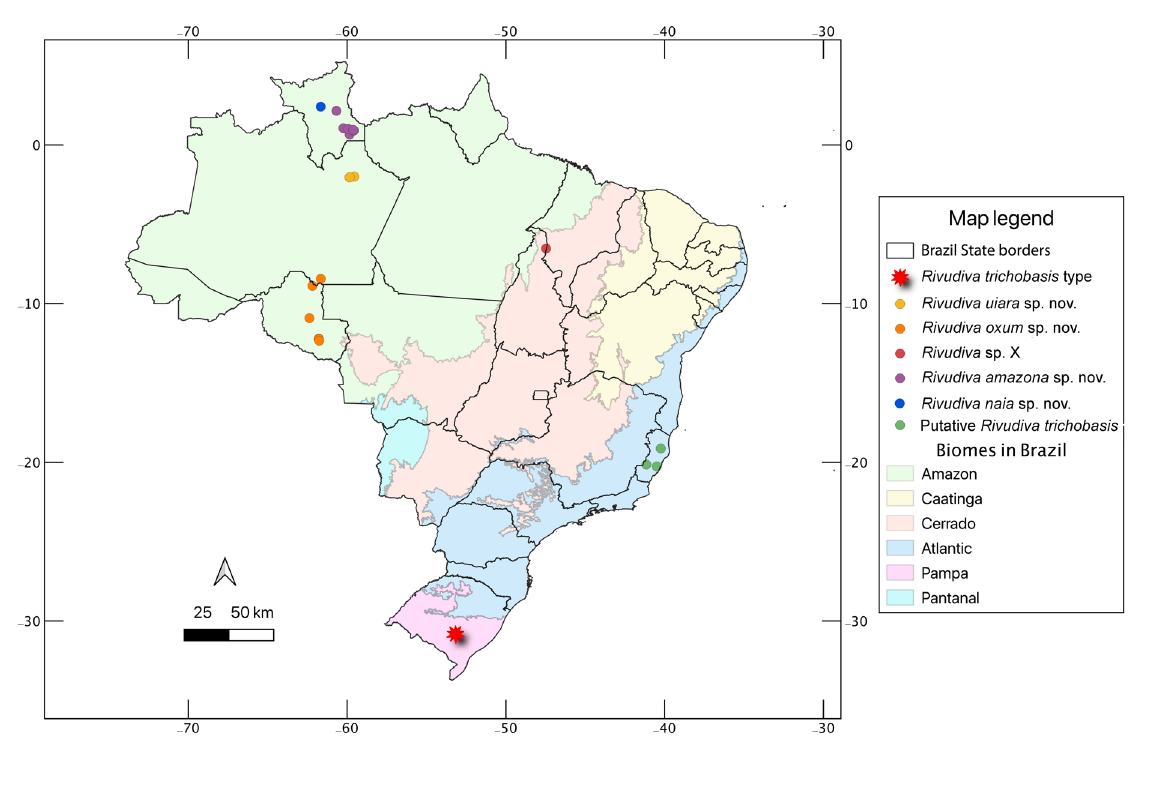
Fig. 21. Map of Brazil showing the distribution of the distinct species of ʻ trichobasis group’ and Brazilian